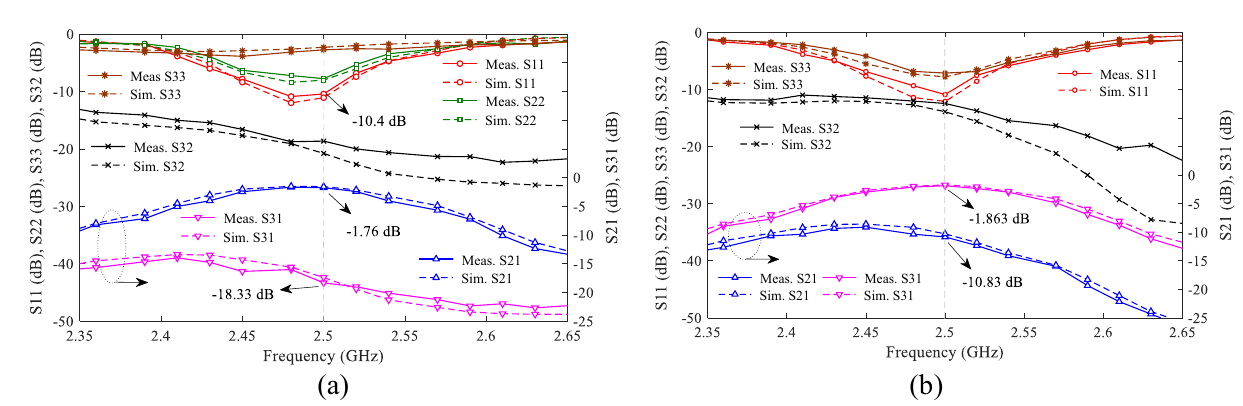
Figure 10. Measurement and simulation results of first design TWPD, ( a ) at V1 = 0 and V2 = 8, and ( b ) at V1 = 8 and V2 =